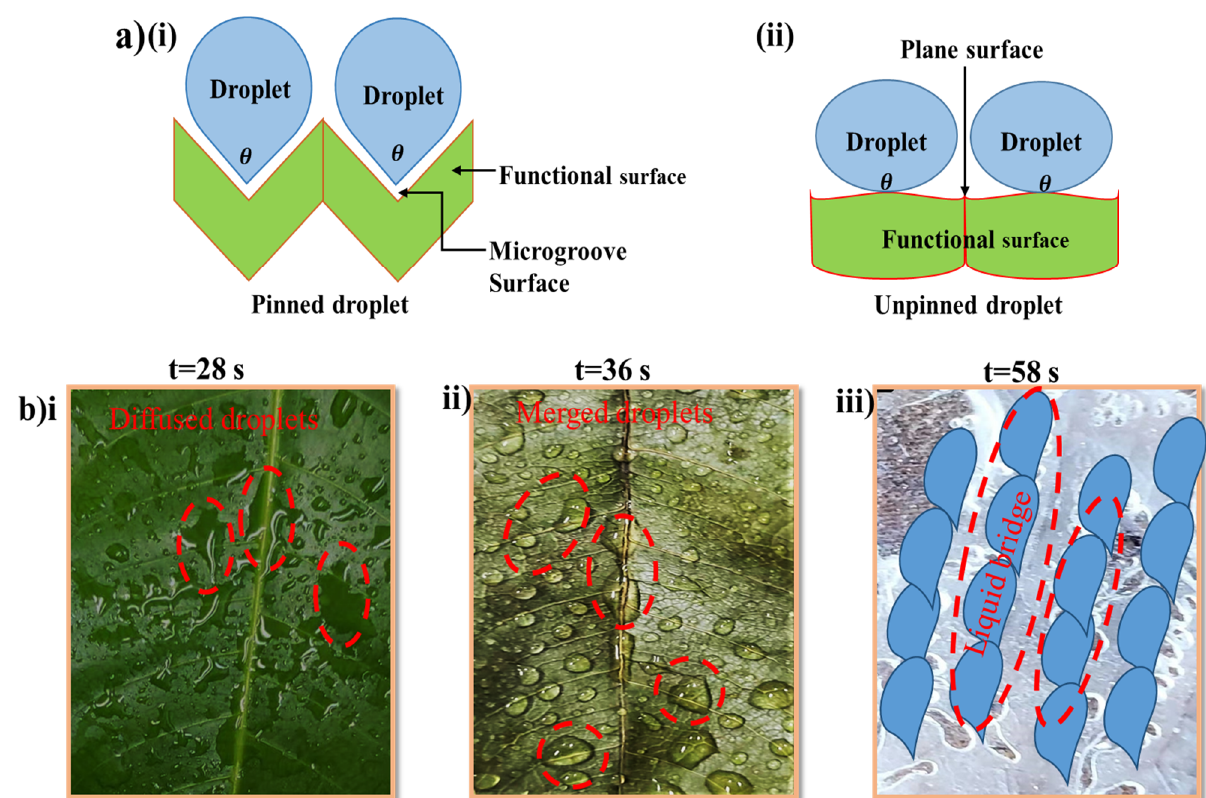
Figure 7. Schematic and photographic images of droplet behavior on functional surfaces; ( a ( i )) pin- ning and ( a ( ii )) unpinning effect of the droplet on a solid surface. ( b ) Coalescence and transportation behavior of droplet on solid surfaces with respect to time ( i ) Fresh Mangifera indica leaf (FMIL), ( ii ) Dry Mangifera indica leaf (DMIL), and ( iii ) Replicated Mangifera indica leaf (RMIL).